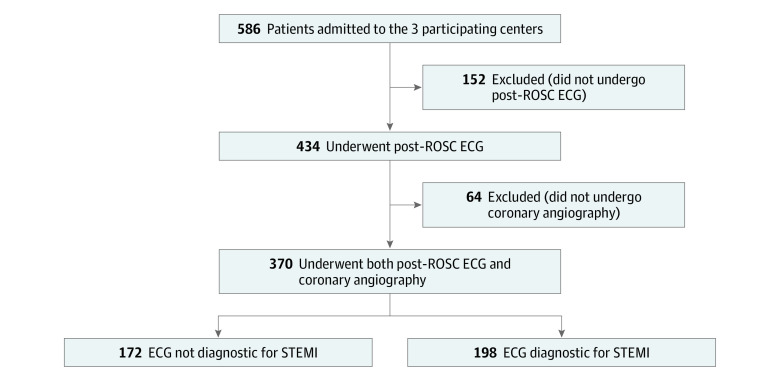
Flowchart of the Study ParticipantsECG indicates electrocardiography; ROSC, return of spontaneous circulation; STEMI, ST-segment elevation myocardial infarction.